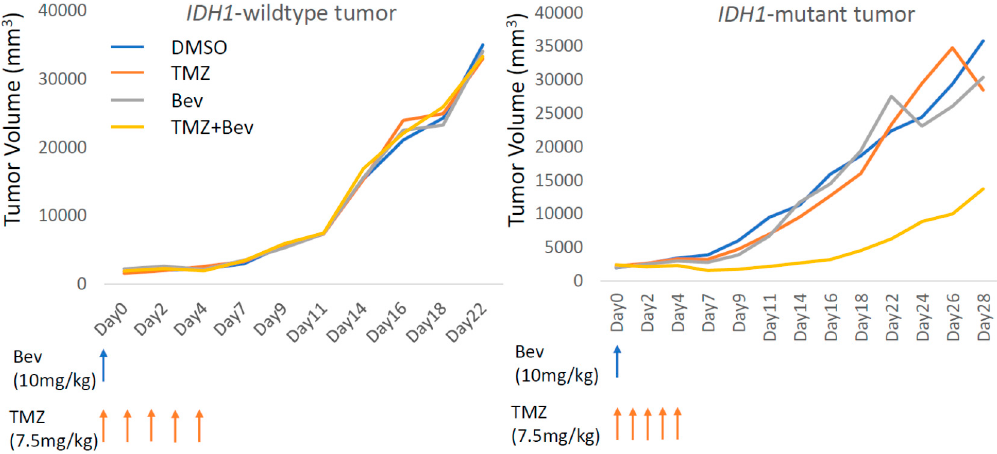
Figure 6. Tumor volume changes in mice xenograft models. A significant antitumor effect was observed only after Temozolomide + Bevacizumab treatment in the IDH1- mutant U87 xenograft model, whereas no antitumor effect was observed in the IDH1 -wiltype U87 xenograft model.